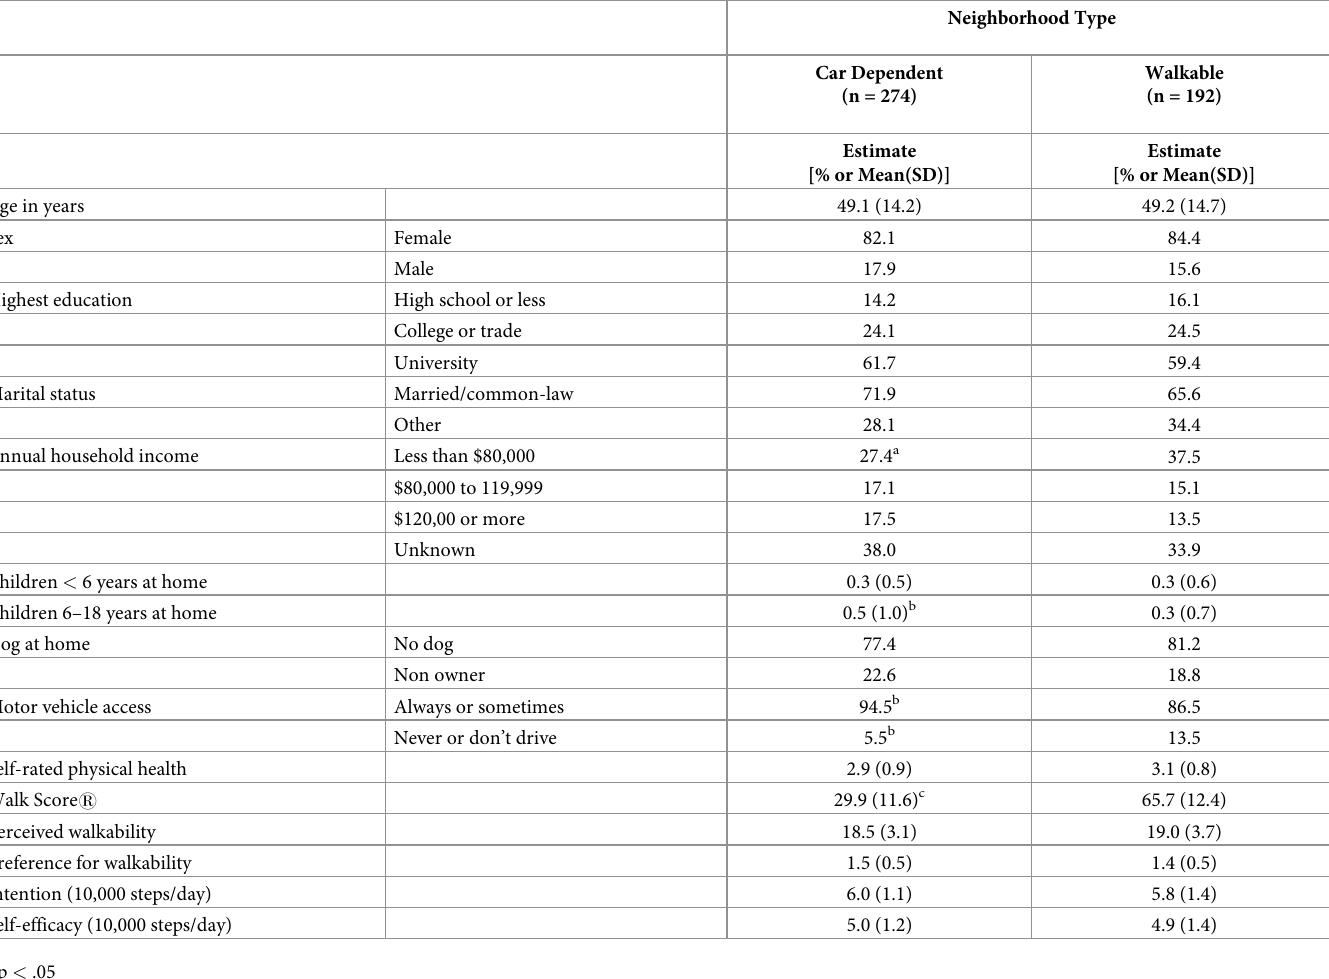
Table 2. Baseline characteristics by neighborhood type among those who registered for